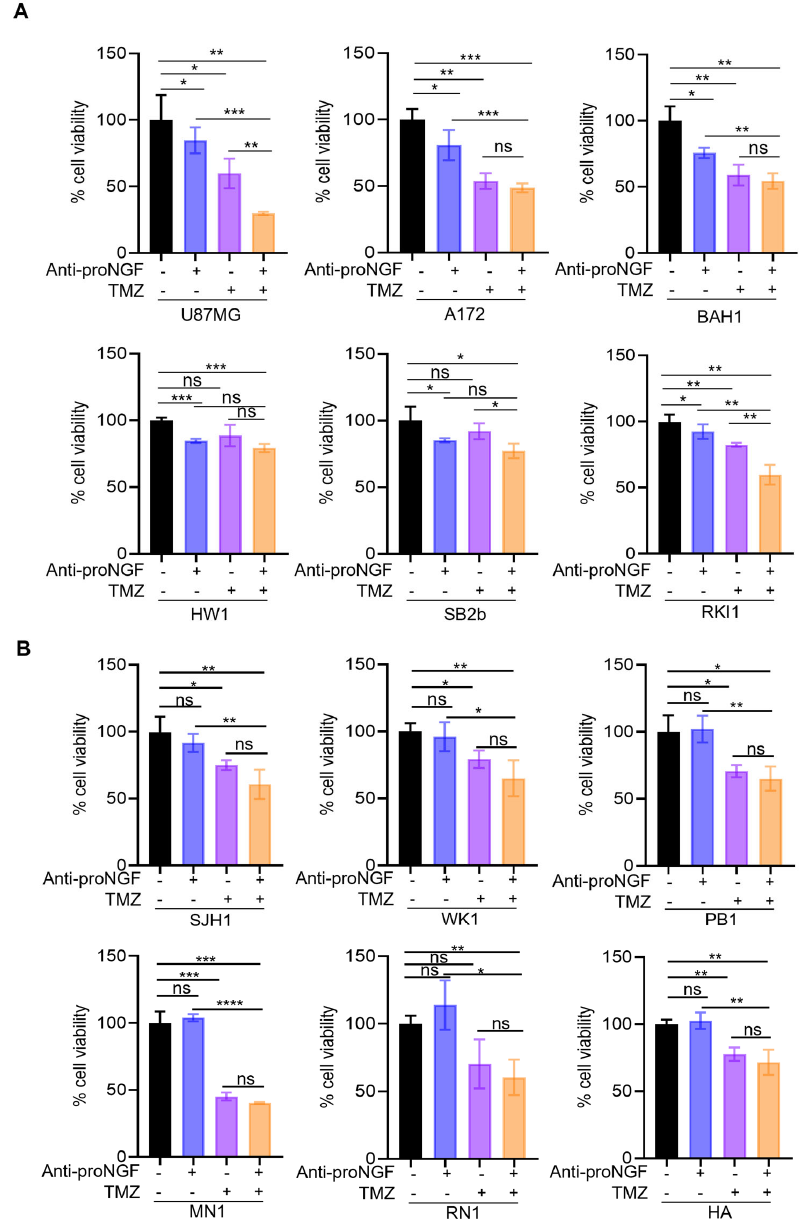
Figure 4. Biological effect of targeting proNGF in GBM cells. GBM cell growth was studied in a panel of GBM cell lines with methylated MGMT gene promoter ( A ) and unmethylated MGMT gene promoter ( B ) as well as human astrocytes (HA, served as a control cell line) treated with blocking antibodies against proNGF (anti ‐ proNGF, 600 ng/mL), TMZ (50 μ M) and anti ‐ proNGF + TMZ for 72 h. Data shown are the mean ± SD of three independent experiments. * p < 0.05, ** p < 0.01, *** p < 0.001, **** p < 0.0001, Student’s t ‐ test or ANOVA. proNGF: precursor for nerve growth factor, TMZ: Temozolomide. Black bars: PBS (vehicle control for anti ‐ proNGF) + DMSO (vehicle control for TMZ); blue bars: anti ‐ proNGF + DMSO (vehicle control for TMZ); purple bars: TMZ + PBS (vehicle control for anti ‐ proNGF); orange bars: anti ‐ proNGF + TMZ.